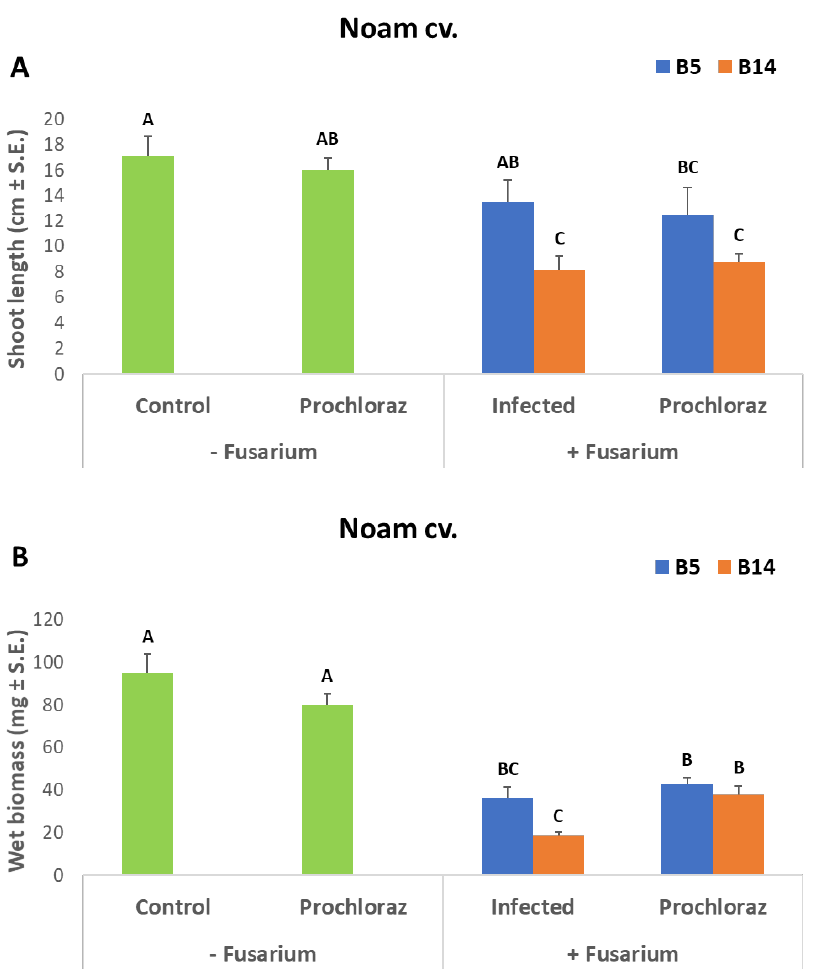
Figure 8. Potted sprouts assay to evaluate the effectiveness of the Prochloraz preparation against Fusarium spp. involved in onion basal rot disease. ( A ). Shoot length ( B ). Wet weight. The plants were inoculated separately with pathogens F. acutatum (isolate B5) and F. oxysporum f. sp. cepae (isolate B14). The Prochloraz (at a concentration of 0.3% w / w ) treatment was performed 14 days after sowing by irrigation with 100 mL tap water per pot. Controls: Untreated and non-inoculated sprouts, non-inoculated sprouts treated in Prochloraz, and infected plants without Prochloraz. Values were measured after 30 days in a growing room with artificial light for 16 h and eight hours in darkness, humidity percentage of 45 – 50%, and a temperature of 28 ± 3 ˚C. The columns represent an average of five repetitions, deviation lines represent a standard error. Different letters above the columns represent a significant difference ( p < 0.05) in the ANOVA test.